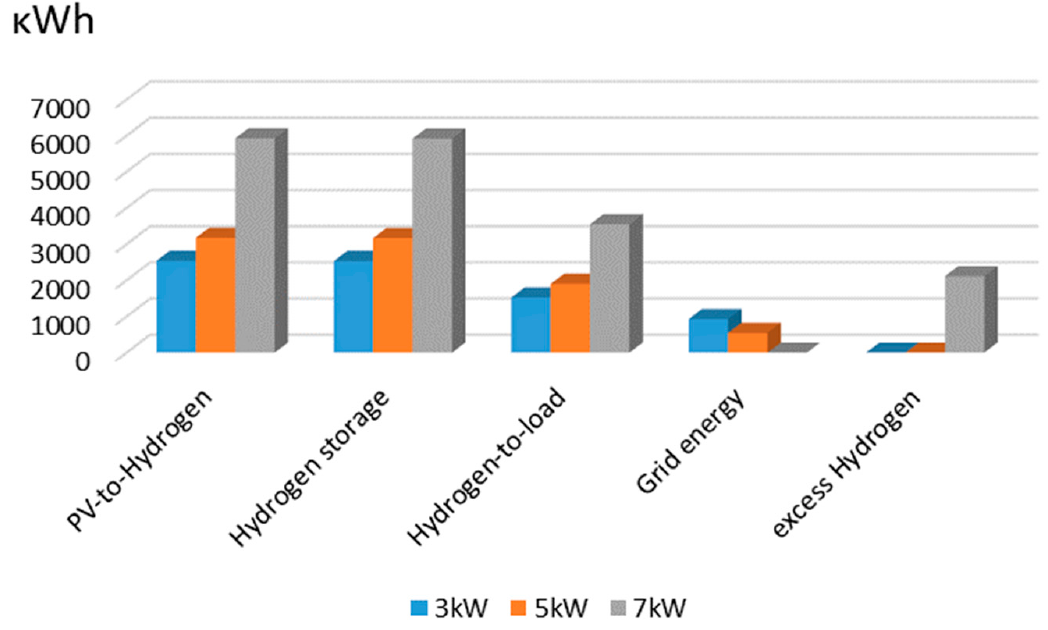
Figure 7. Simulation results in the absence of a power conditioning system.